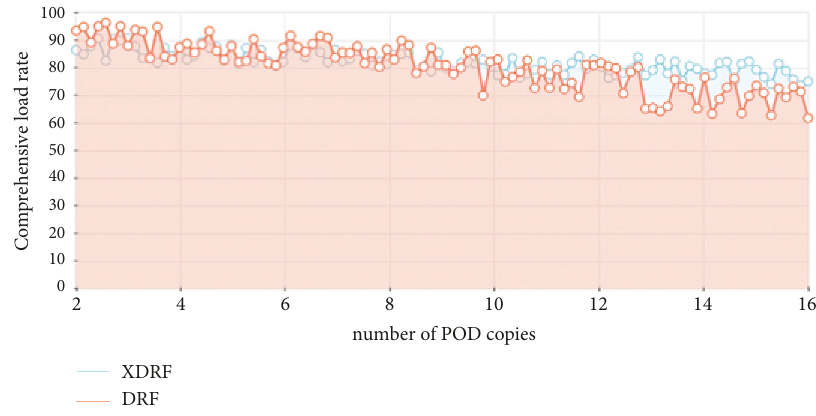
Figure 4: XEDI-PODS CPU-RAM comprehensive load rate change trend.